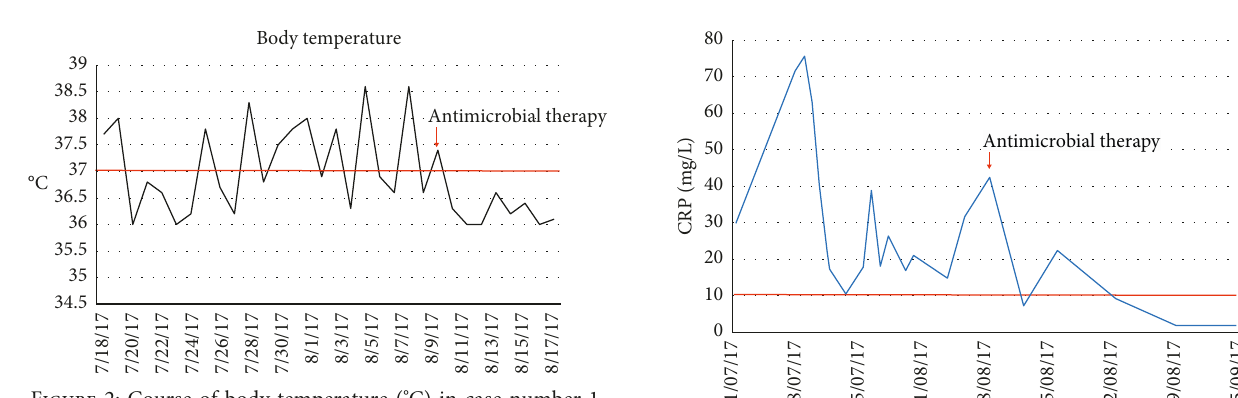
Figure 2: Course of body temperature ( ° C) in case number 1.